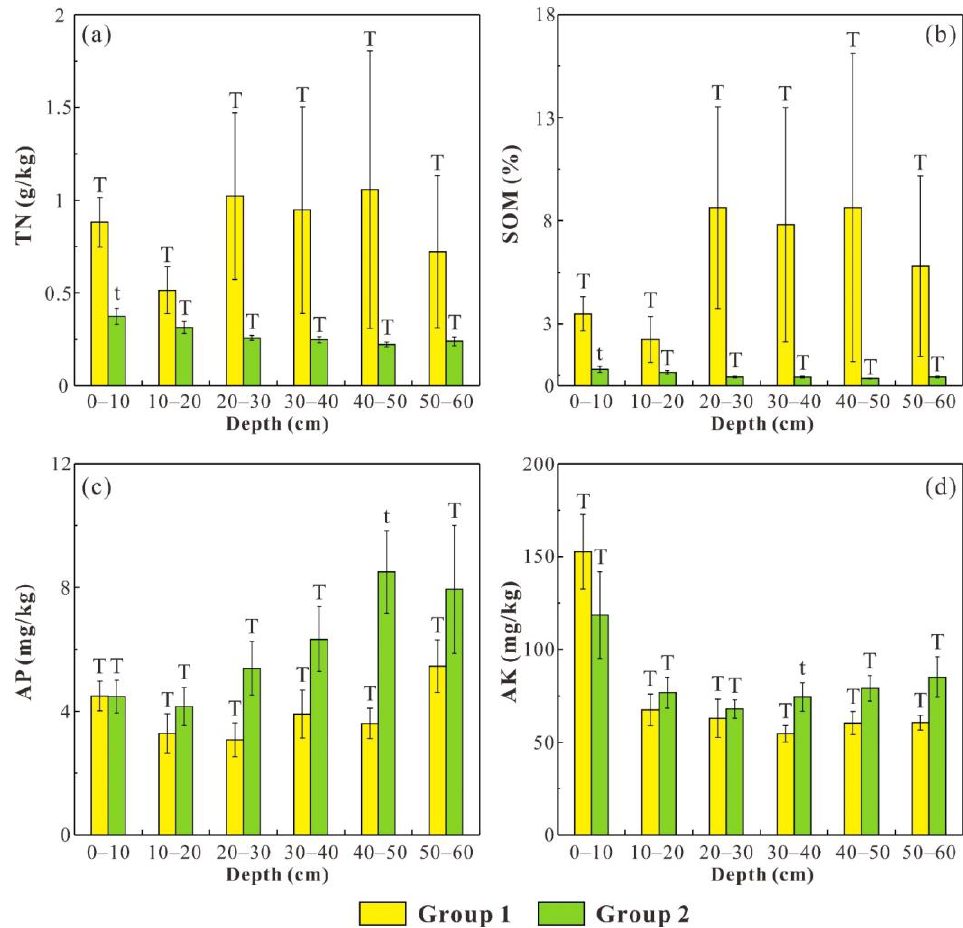
Figure 5. The average contents of TN ( a ), SOM ( b ), AP ( c ) and AK ( d ) in group 1 and group 2 (the classification of the two groups is based on the K factor values). The error bar represents the standard error and different forms of T denote significant difference.